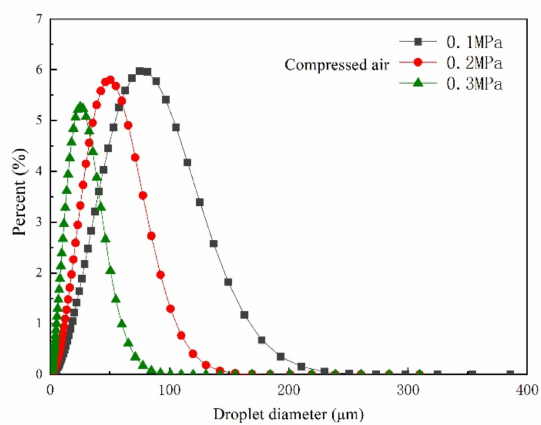
Figure 6. The droplet diameter distribution with different compressed air